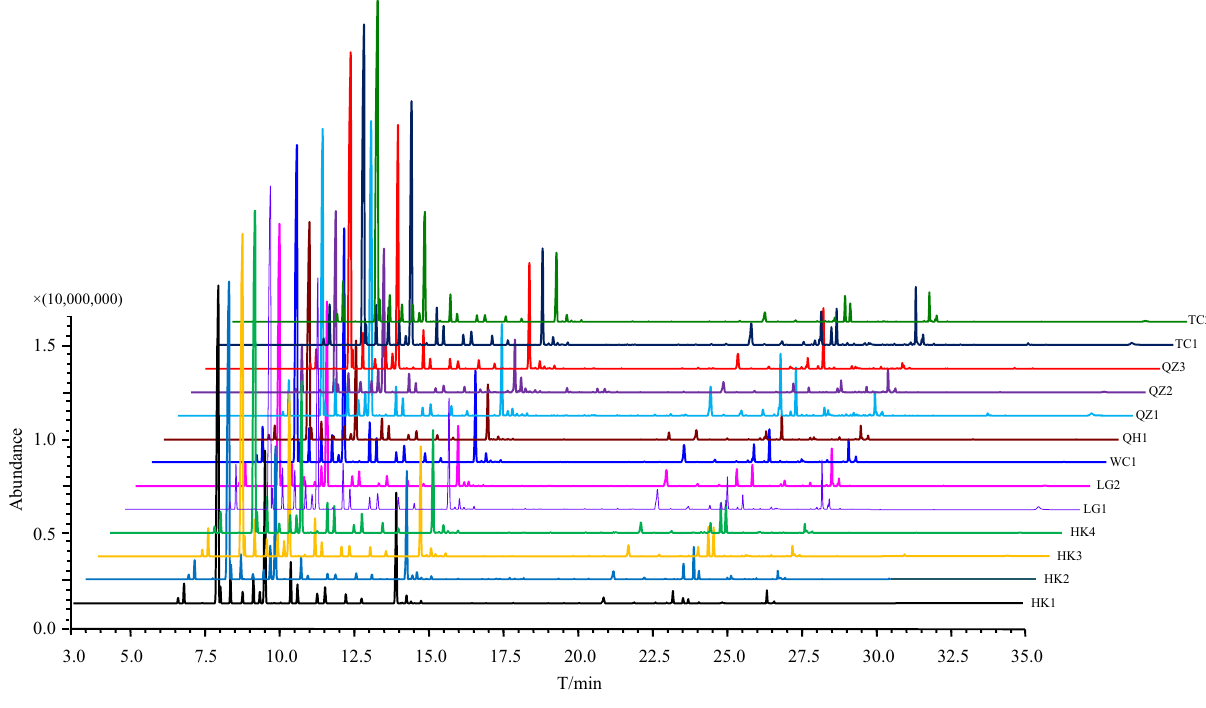
Figure 1. GC–MS chromatograms of EOs of C. lansium seeds. ( a T: retention